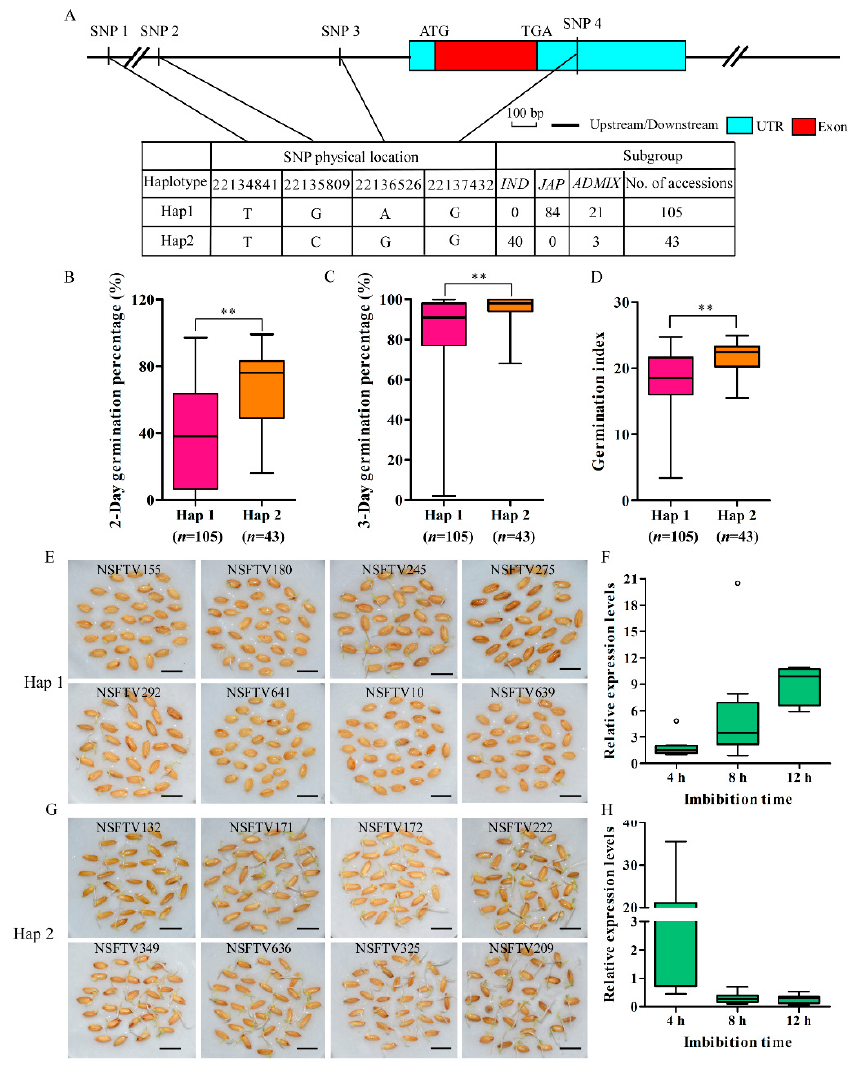
Figure 8. Haplotypes of OsSAUR33 associated with seed vigor in rice. ( A ) Haplotypes of OsSAUR33 identified in the region from ~2 kb upstream of the gene and its coding region. ( B – D ) Comparison of the germination percentage and germination index between accessions harboring different haplotypes. The number of rice accessions is listed in brackets. ** indicates significant difference at the 1% level according to Student’s t -test. ( E , G ) Seed germination (after 3 days) of accessions harboring different haplotypes. Bars = 10 mm. ( F , H ) Relative expression levels of OsSAUR33 in rice accessions harboring different haplotypes during seed germination using qRT-PCR. The expression of genes was normalized to that of OsActin . Box plots represent the interquartile range, the thick line in the middle of each box represents the median, the whiskers represent 1.5 times the interquartile range, and the black circles represent outlier points.